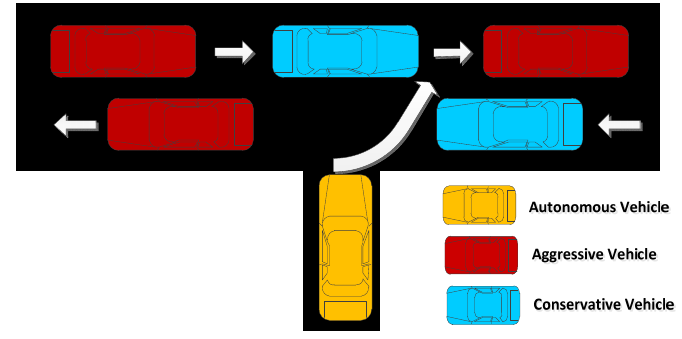
Figure 2. An uncontrollable T-intersection.